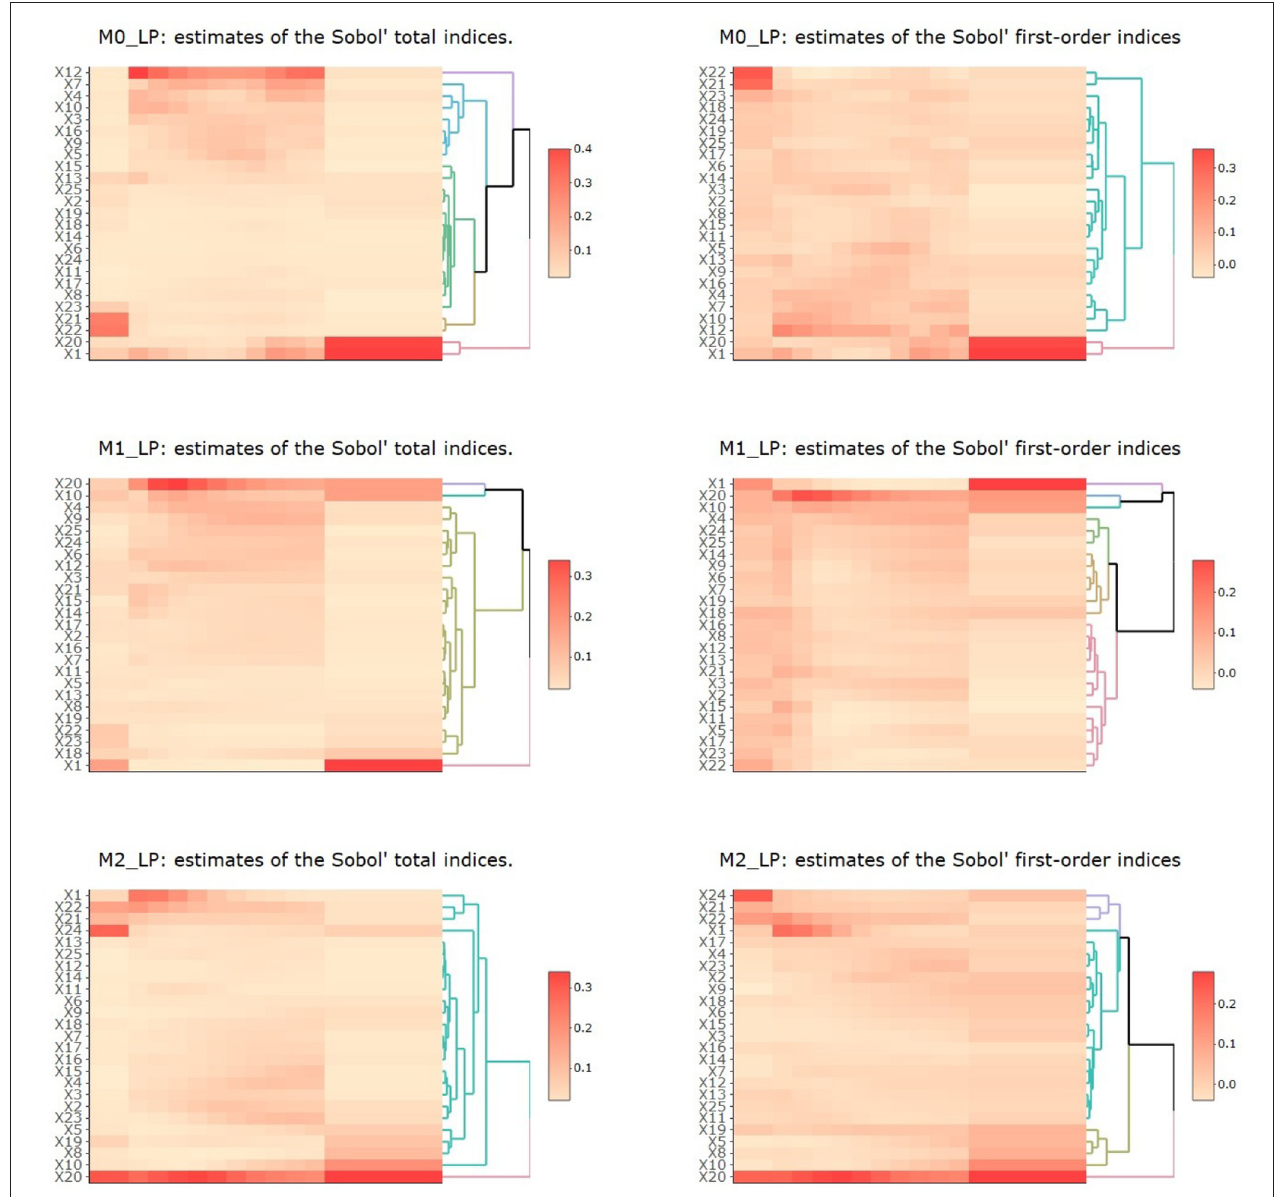
FIGURE 5 | Heatmaps of estimates of Sobol’ total and first-order indices for the 25 input parameters with respect to outputs M0_LP, M1_LP, and M2_LP. In each plot, the vertical axis denotes the 25 inputs and the horizontal axis denotes the three time periods T 1 to T 3 , with T 2 being further divided into 10 time